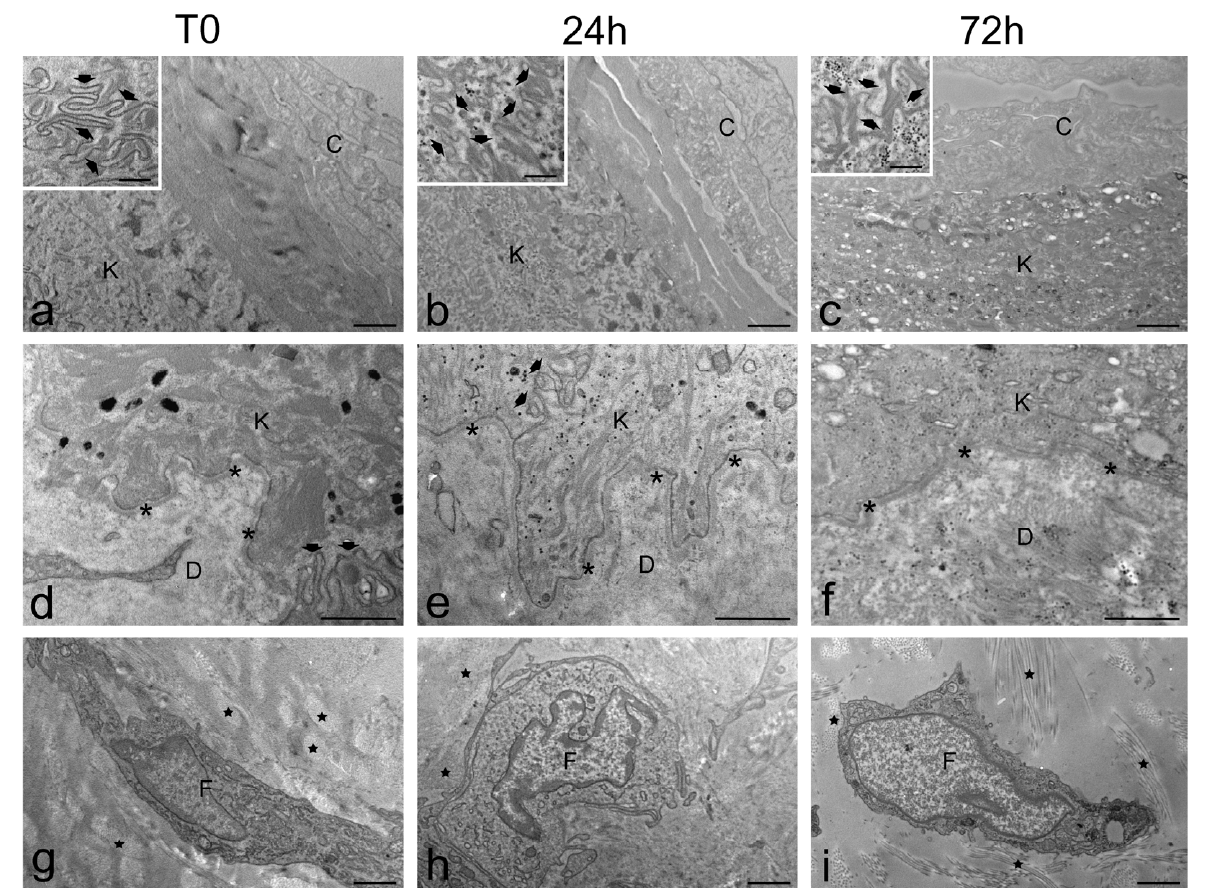
Figure 2. TEM micrographs of control (untreated) human skin explants at T0 (immediately after excision) and after 24 h and 72 h in the bioreactor. Note the good preservation of the outer epidermis layer ( a – c ), with clearly recognizable corneocytes (C) and keratinocytes (K), and the basal epidermis layer ( d – f ), where keratinocytes (K) are connected to the dermis (D) by the basal membrane (asterisks). Insets show intercellular junctions (arrowheads) between keratinocytes; intracellular junctions are present also between keratinocytes of the basal layer (arrowheads in ( d , e )). The papillary dermis ( g – i ) also shows good preservation, with fibroblasts (F) surrounded by collagen bundles (stars). Bars: 1 µm ( a – i ); 200 nm (insets in ( a – c )).